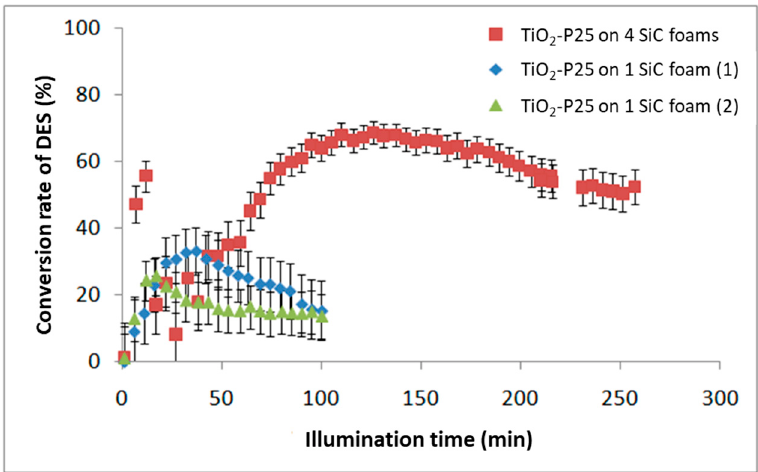
Figure 4. Degradation tests of DES under UV-A irradiation with TiO 2 P25 supported on 1 and four β -SiC foam samples.